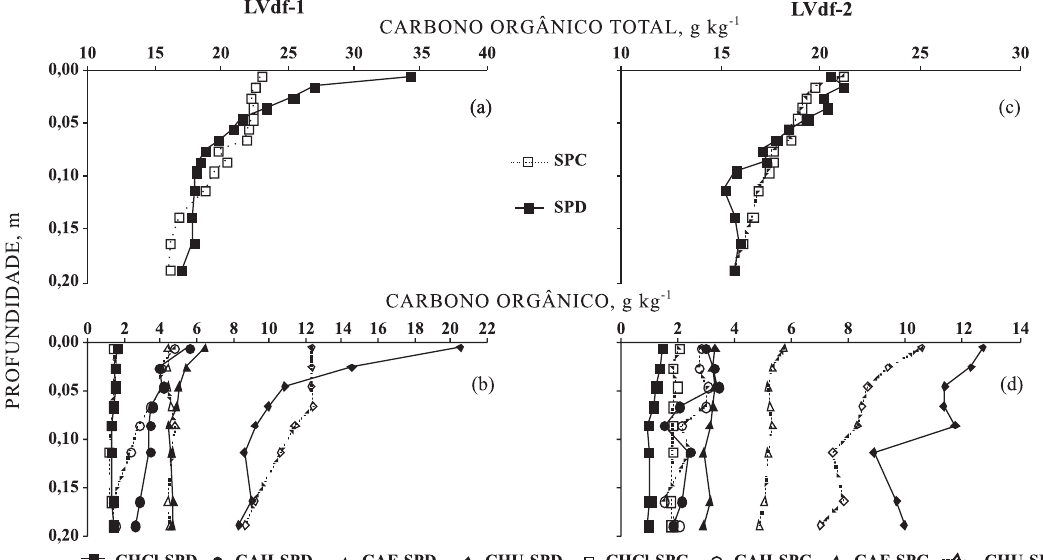
insolúvel.Figura 3. Teores de carbono orgânico total e das frações húmicas da matéria orgânica do solo ao longo da camada superficial dos solos LVdf-1 (a, b) e LVdf-2 (c, d), em sistema de preparo convencional (SPC) e sistema plantio direto (SPD). C - compostos orgânicos de baixo peso molecular; C HCl C - ácidos fúlvicos; C - fração residual AF HU